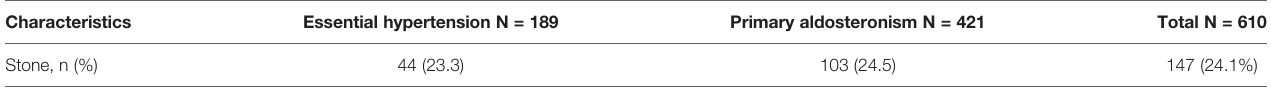
TABLE 1 | The numbers of subjects with kidney stone disease divided by essential hypertension and primary aldosteronism. Characteristics